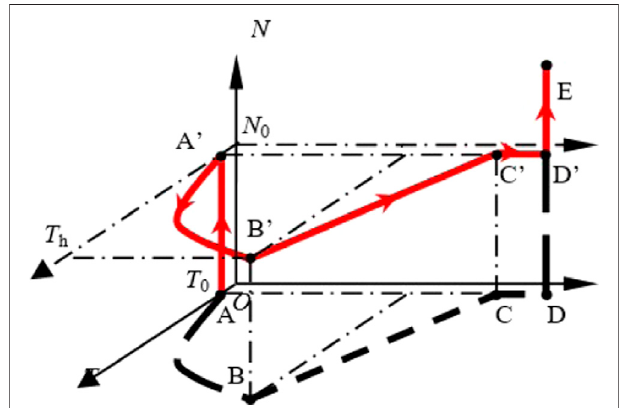
FIGURE 1 | Temperature-load-time curve.